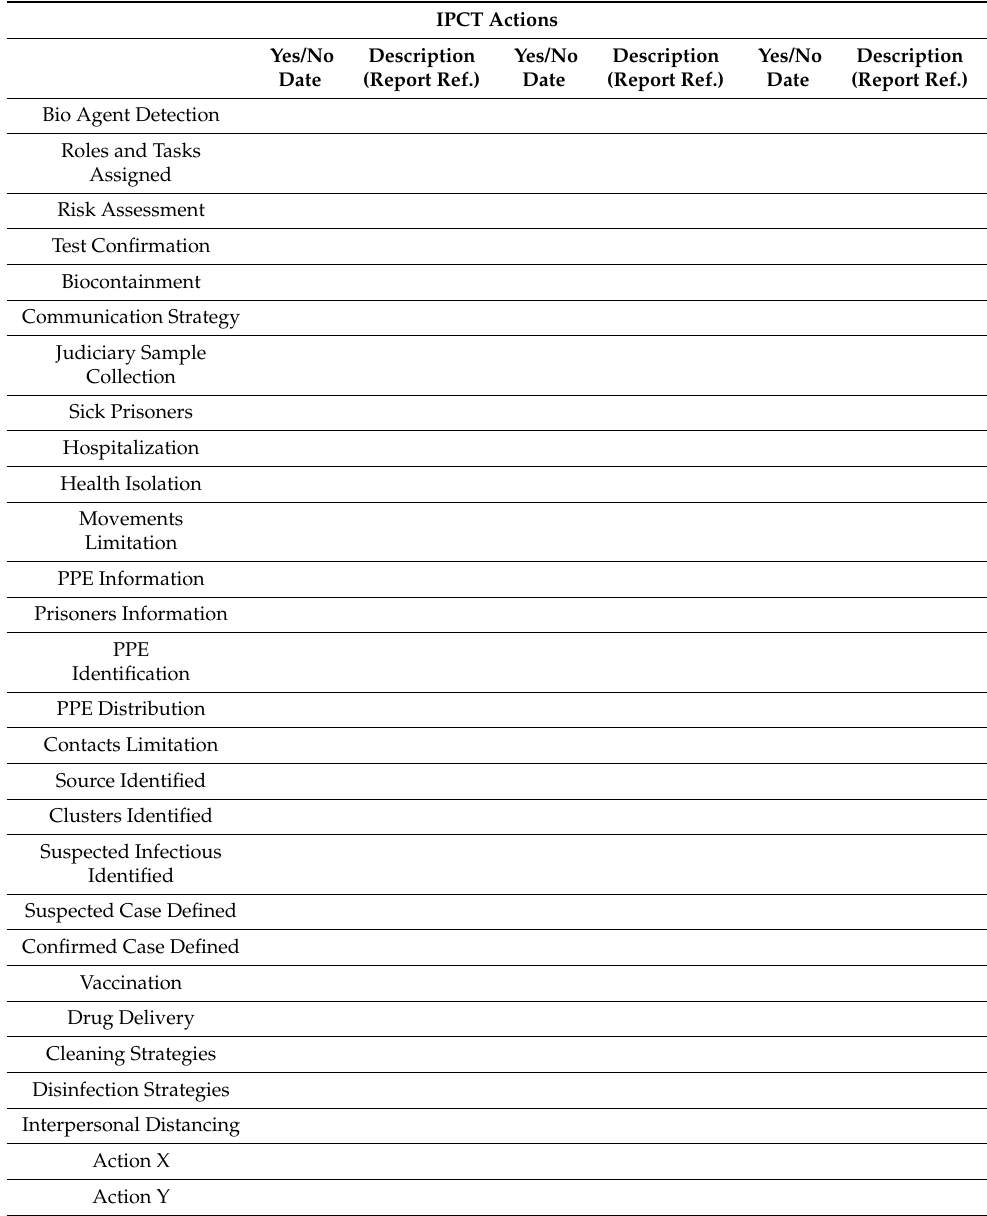
Table 5. A checklist to record every single IPCT